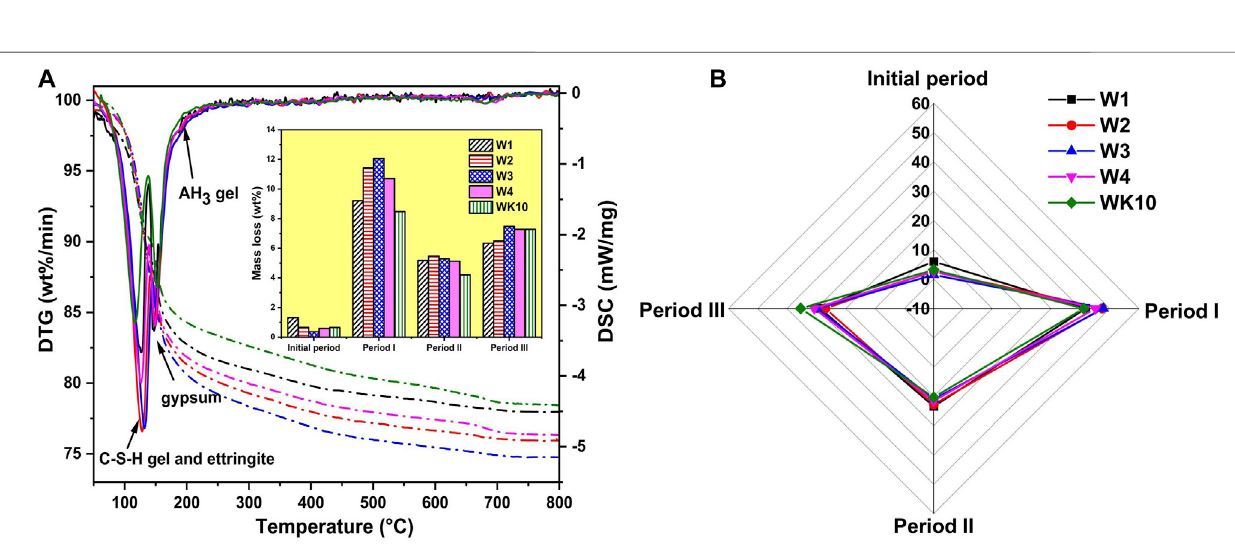
Frontiers in Physics |